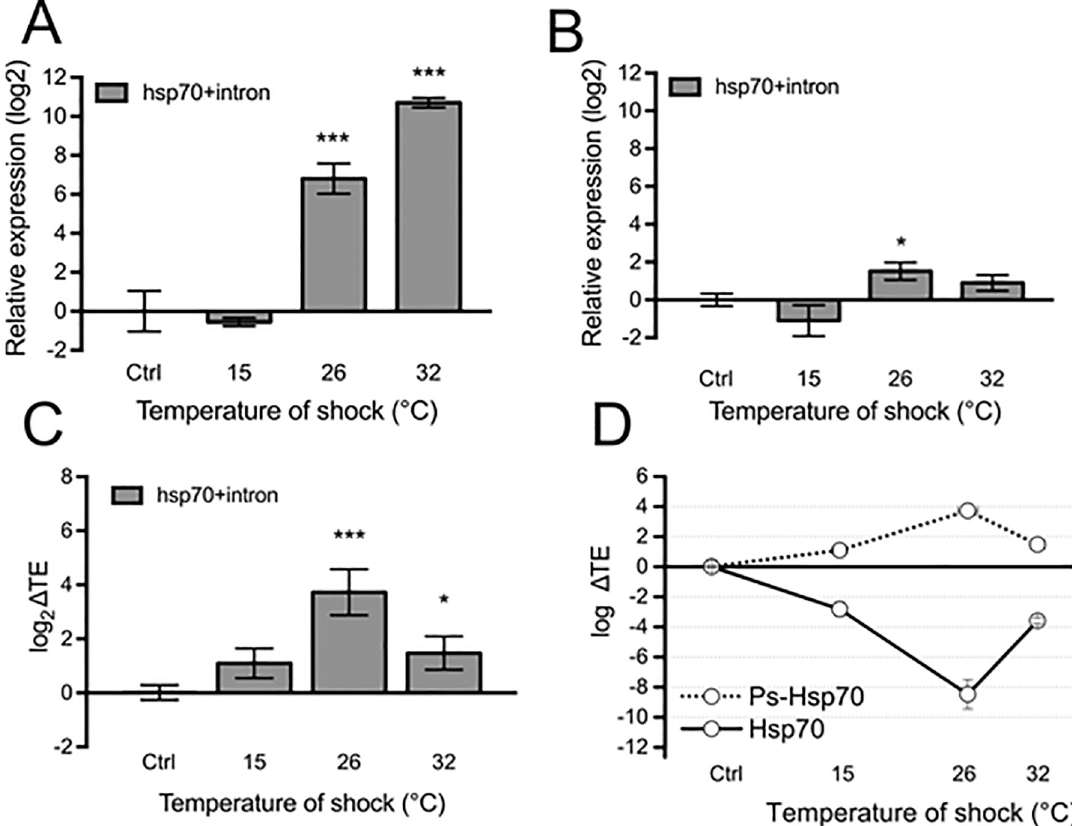
Fig 4. Ps-Hsp70 is loaded on polysomes and acts as a putative ribosome sponge for Hsp70. ( A ) Transcriptional expression level for hsp70 + intron mRNA. Total RNA was extracted from Diamesa tonsa larvae control (K, 4˚C) or maintained for 1 h at 15, 26, and 32˚C. Relative expression level was measured by real-time PCR. Actin was used as housekeeping gene and the level of control (Ctrl, 4˚C) was set at 0. Error bars represent SE; n = 3 biological replicates and each assay performed in triplicate. ( B ) Translational expression level of hsp70 + intron . Polysomal RNA was extracted from sucrose fractions corresponding to the polysomal peaks of larvae control (4˚C) or maintained for 1 h at 15, 26, and 32˚C. Relative expression level was measured by real-time PCR. Actin was used as housekeeping gene and the level of control (4˚C) was set at 0. ( C ) Translation Efficiency (log 2 Δ TE), calculated as the difference between the fold change at the polysomal level and the fold change at the sub-polysomal level, of hsp70 + intron in larvae control (Ctrl, 4˚C) or maintained for 1 h at 15, 26, and 32˚C. Asterisks indicate statistically significant differences in respect to the control (Student t -test, � p � 0.05, �� p � 0.01, ��� p � 0.001). ( D ) Comparison between the Translation Efficiency (log 2 Δ TE) of Ps-Hsp70 and Hsp70. The Δ TE values for Hsp70 were obtained from data shown in Fig 3B and